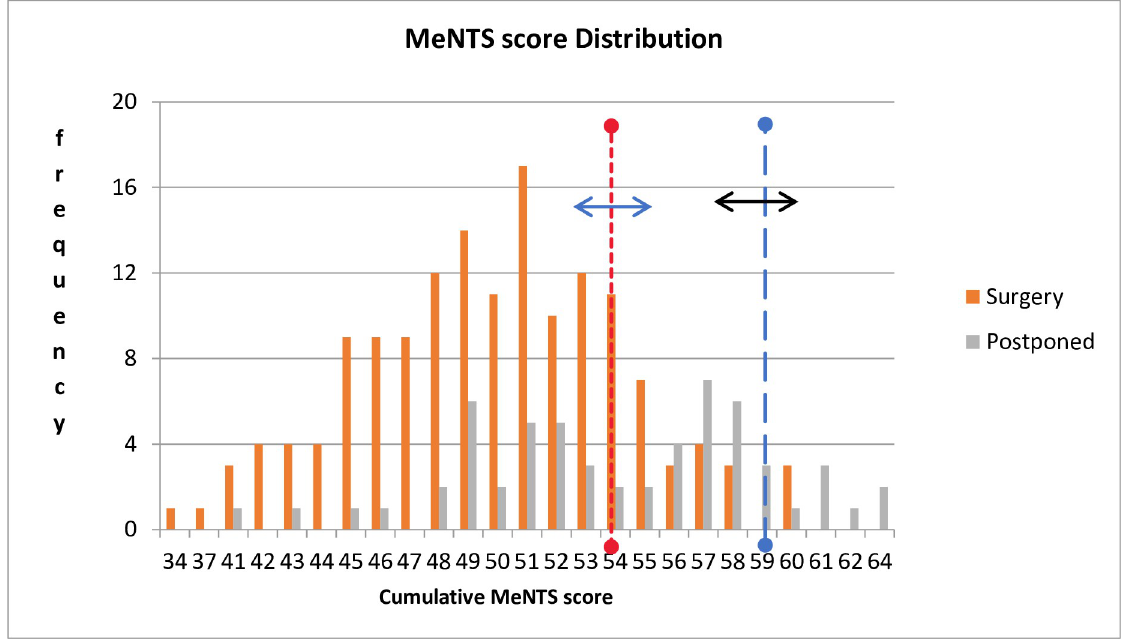
Fig 1. The column graph showing the distribution of MeNTS